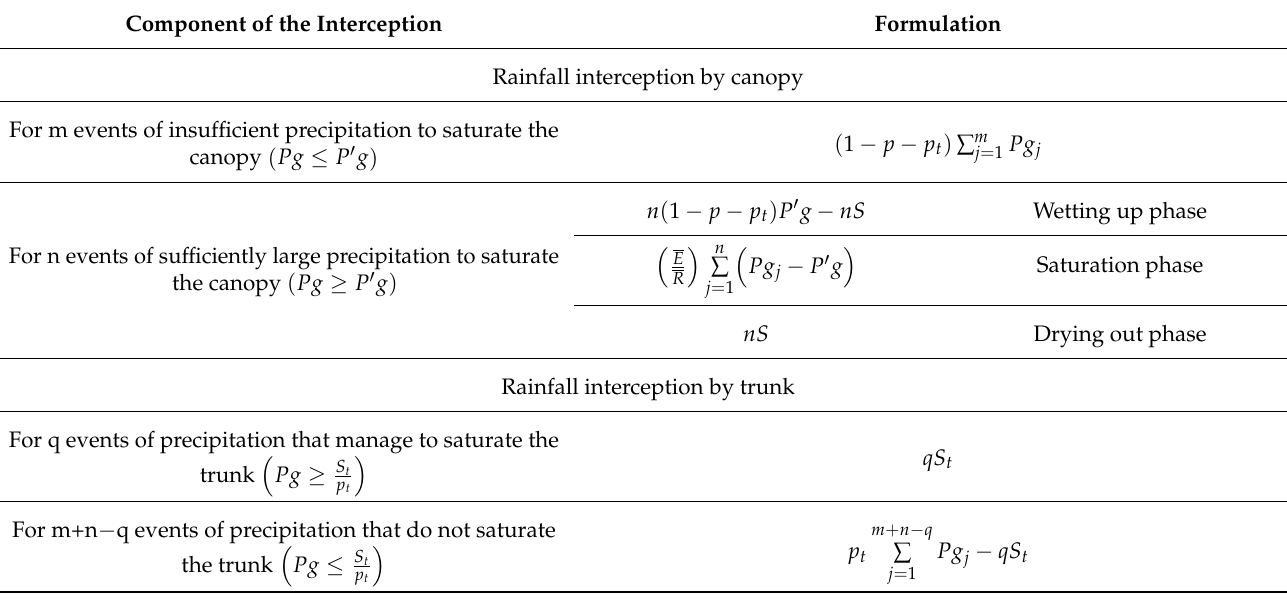
Table 1. Components of rainfall interception for the Gash model. Component of the Interception Formulation Rainfall interception by